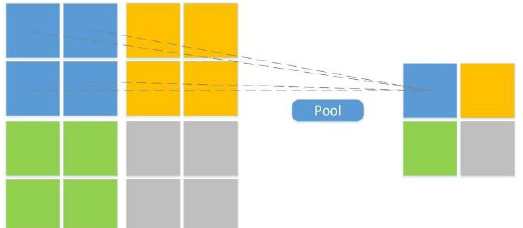
Figure 4. Illustration of pooling layer. The pooling layer with filters of size 2x2 and stride of 2 was shown